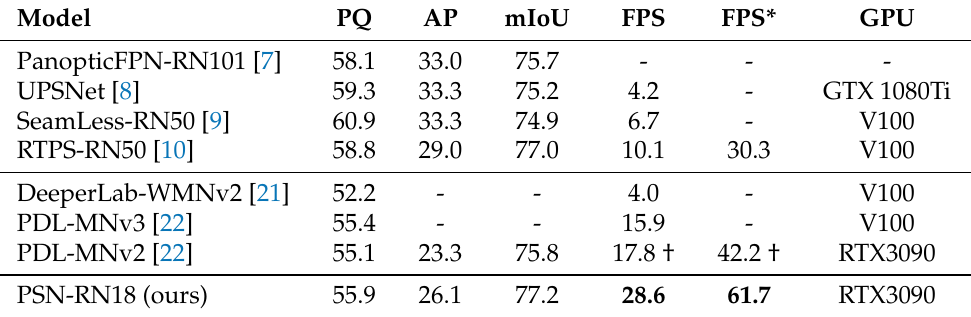
Table 3. Panoptic segmentation performance on Cityscapes val. Sections correspond to top-down methods based on Mask R-CNN (top), bottom up methods (middle), and our methods based on pyramidal fusion (bottom). FPS denotes frames per second from PyTorch and Python. FPS* denotes frames per second with FP16 TensorRT optimization. †—denotes our